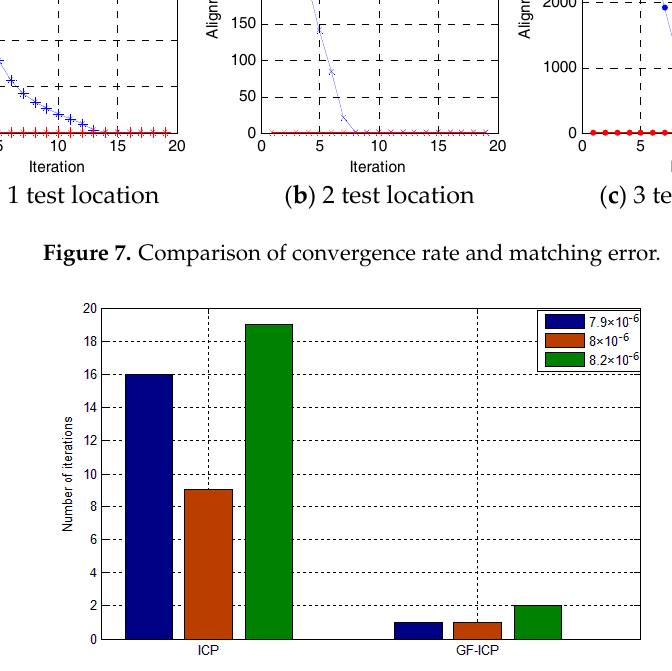
Figure 8. The number of iterations required by the two methods under the same accuracy.